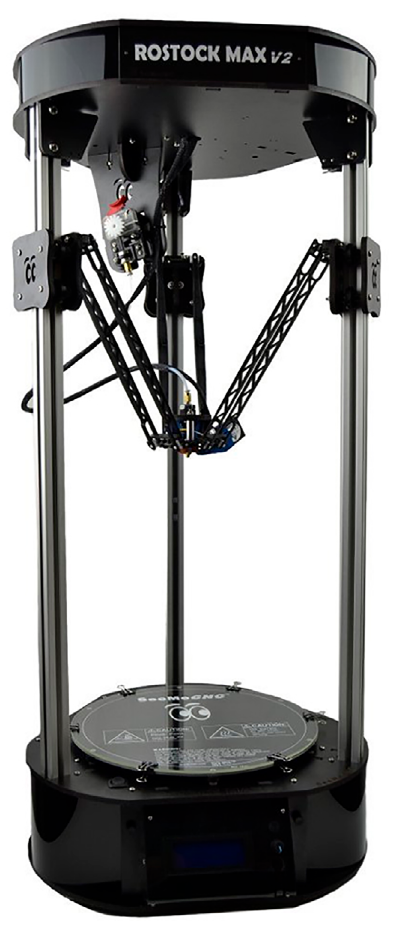
Figure 4. Rostock Max V2 Printer. Source: